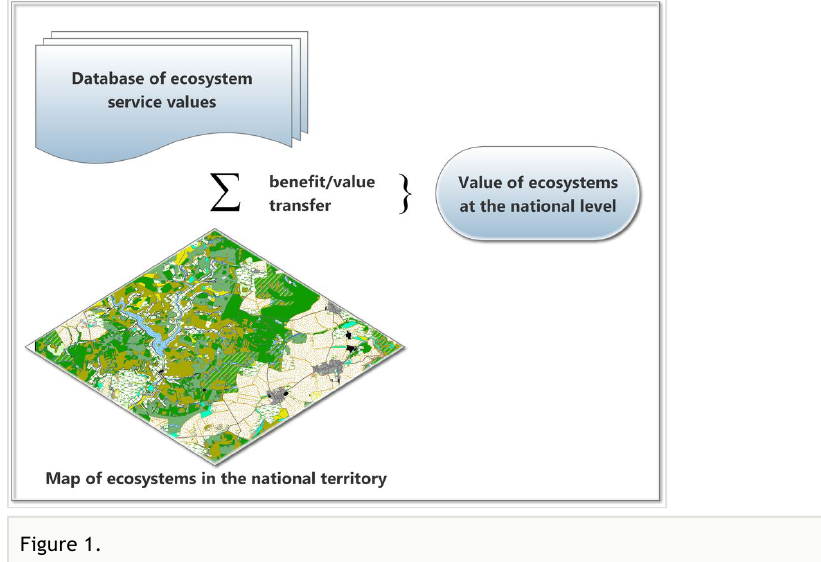
Figure 1. Scheme of ecosystem service valuation at the national